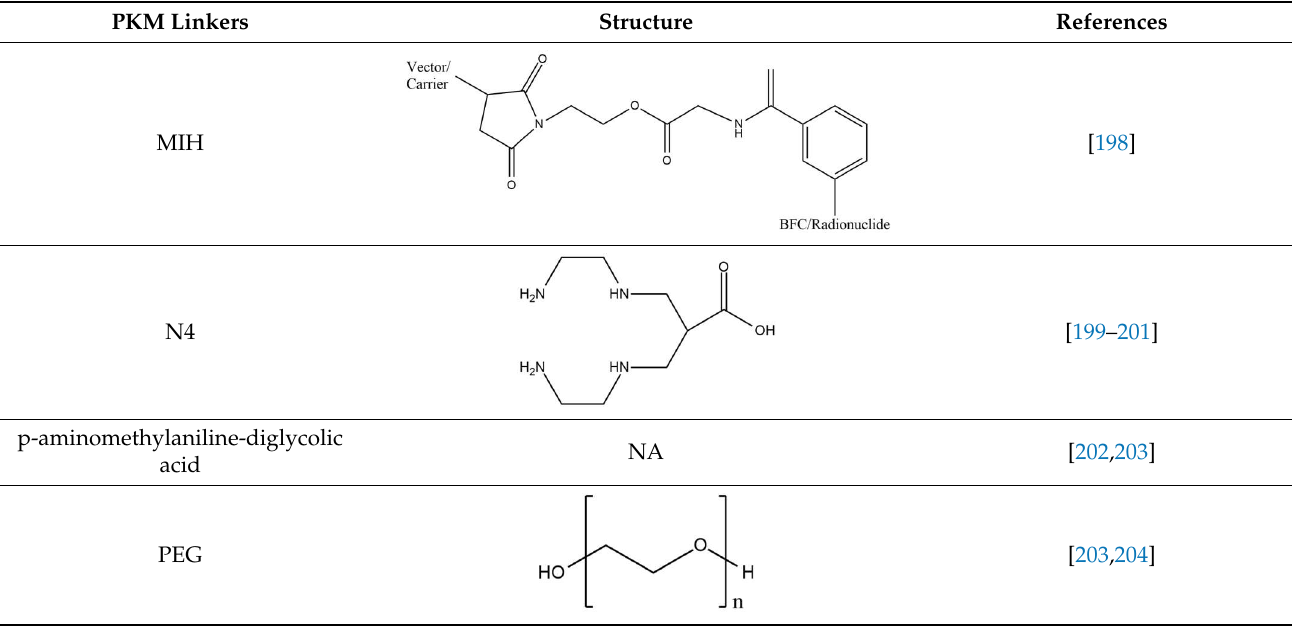
Table 5. Cont. PKM Linkers